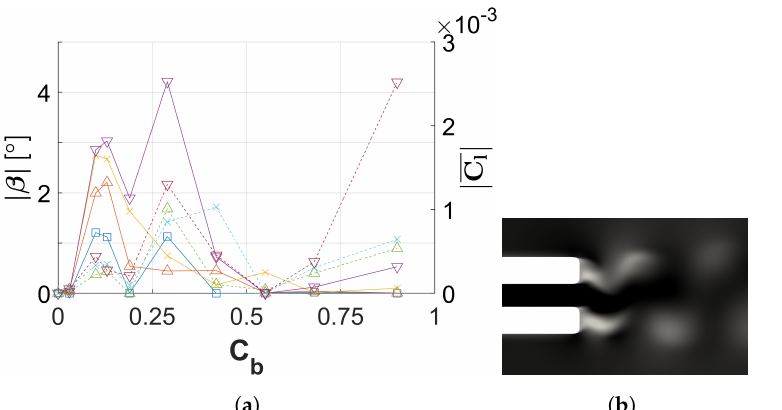
Figure 10. ( a ) Absolute value of the jet angle, | β | , (continuous lines) and averaged lift coefficient, C l , against non-dimensional base bleed rate (dashed lines). Results for constant (- (cid:3) -) [19] and pulsating base bleeds at 100 Hz (- (cid:52) -), 150 Hz (- × -), and 200 Hz (- (cid:53) -). ( b ) Snapshot of base region velocity contours, illustrating base bleed jet angle